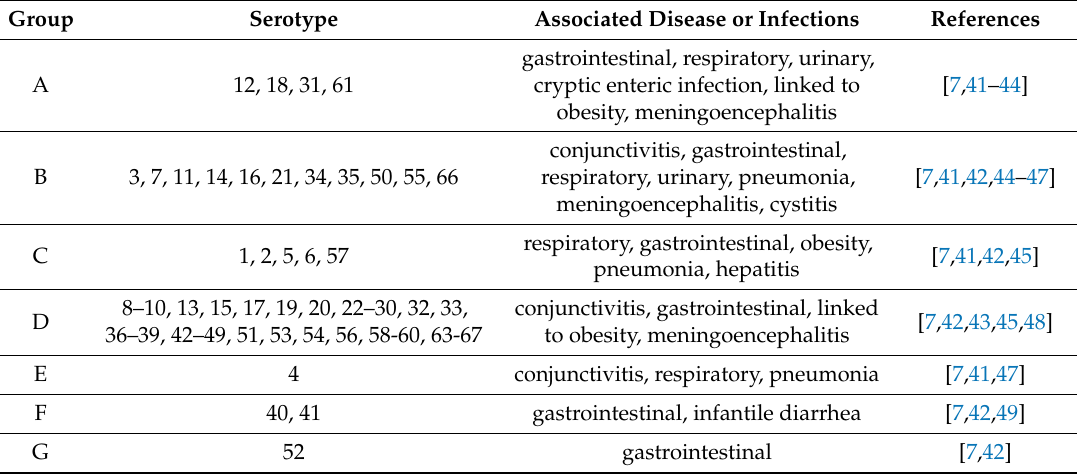
Table 1. Human adenoviruses (HAdV)-associated diseases or infections. HAdVs are members of the family Adenoviridae and genera Mastadenovirus and are associated with an array of diseases. HAdV is classified into seven groups (A–F). There are more than 100 serotypes, and approximately 67 serotypes (1–67) are known to be pathogenic in